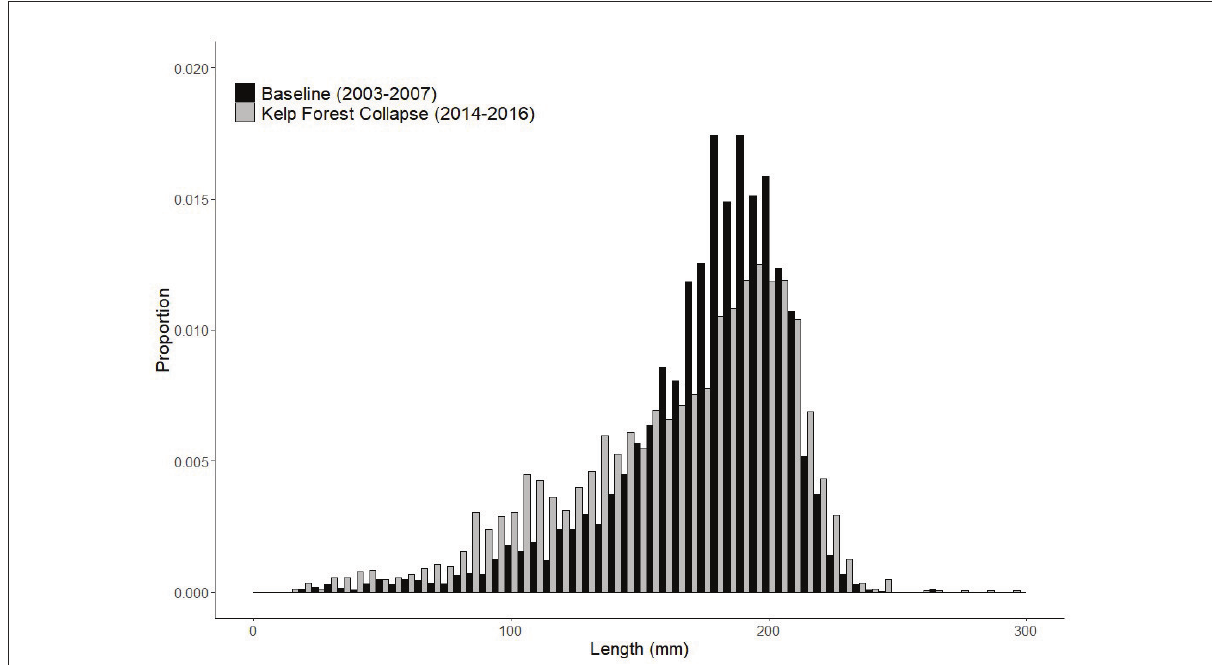
FIGURE4 Size frequency distribution comparing abalone sizes in baseline years (2003–2007) with abundant kelp forest with abalone sizes after the kelp forest collapsed (2014–2016).